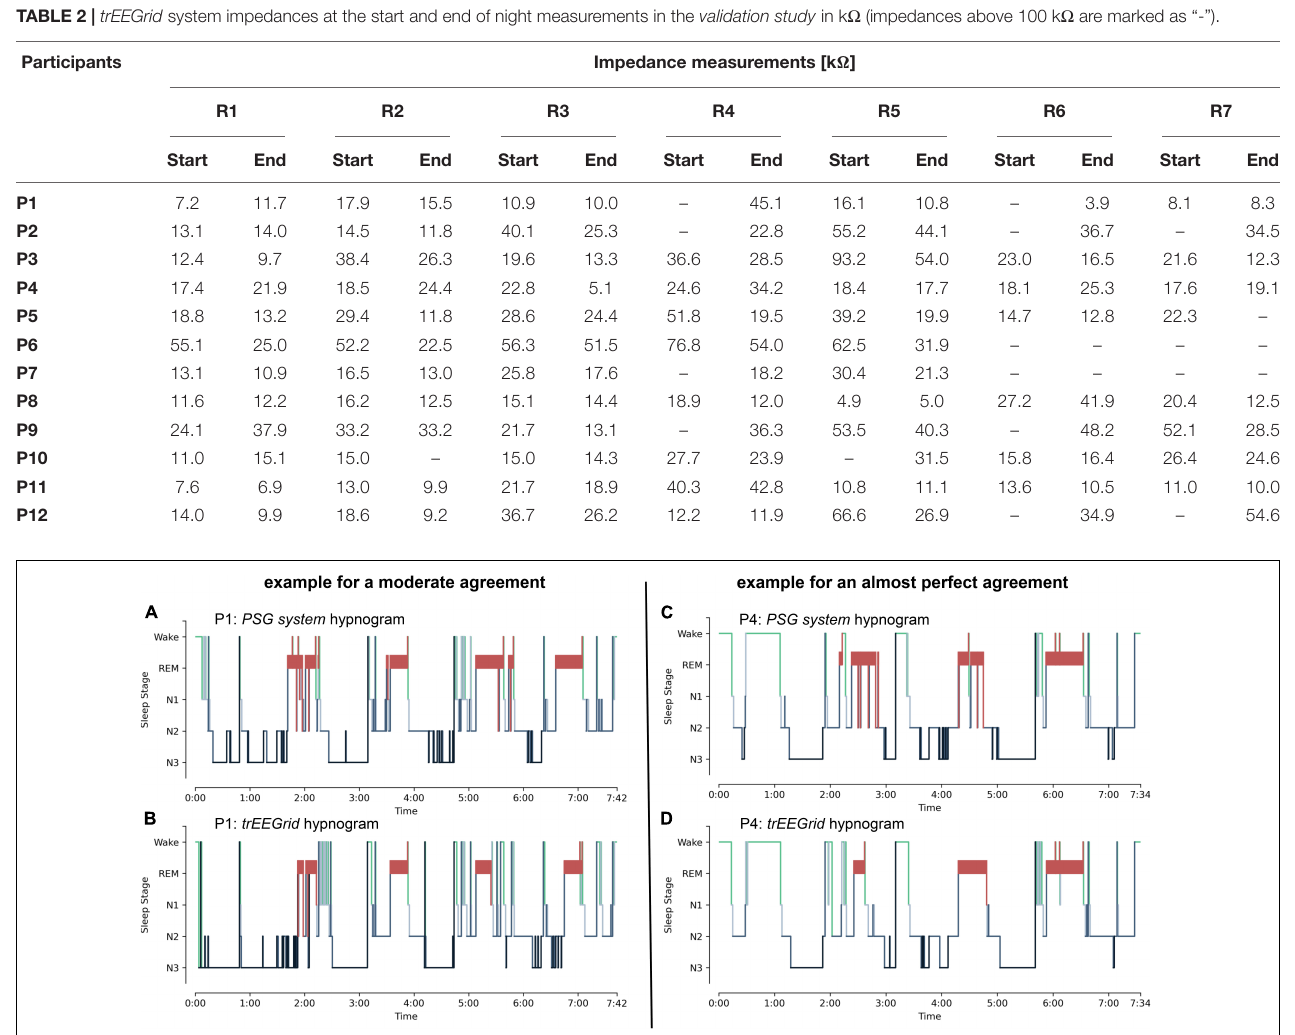
FIGURE 4 | Exemplary hypnograms, shown for participants P1 and P4. (A,B) Hypnograms of P1 show a moderate agreement. (C,D) Hypnograms of P4 show an almost perfect agreement. The sleep stages are defined according to the AASM as: Art (Artifact), Wake (Wakefulness), REM (Rapid Eye Movement), N1 (non-REM1), N2 (non-REM2) and N3